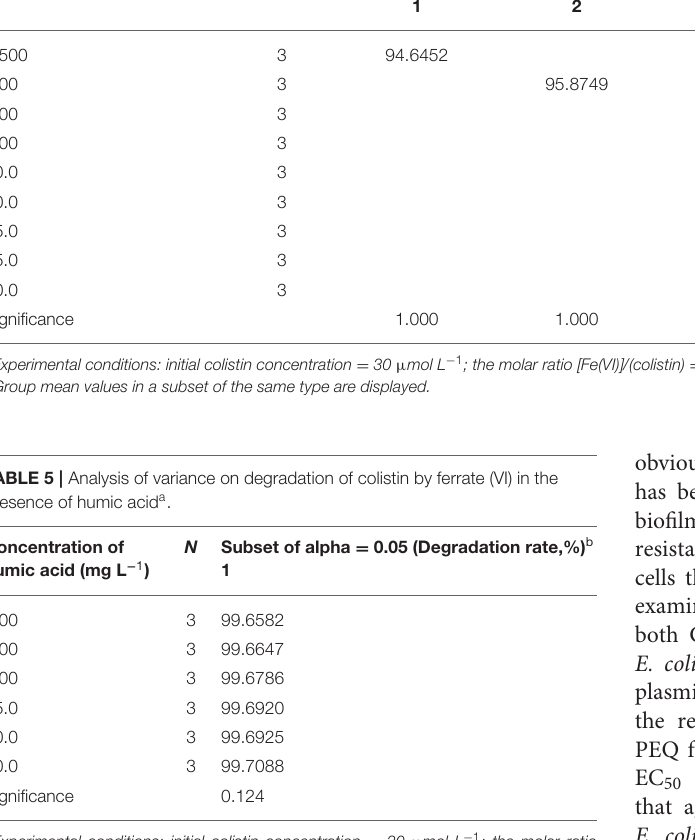
TABLE 4 | Analysis of variance on degradation of colistin by ferrate (VI) at different reaction duration a . Reaction duration (min) N Subset of alpha = 0.05 (Degradation rate,%) b 1